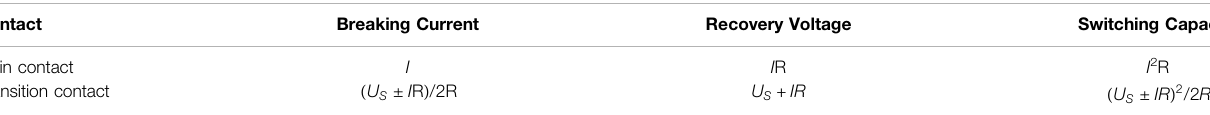
TABLE 1 | Characteristic variables in tap changing process of OLTC. Contact